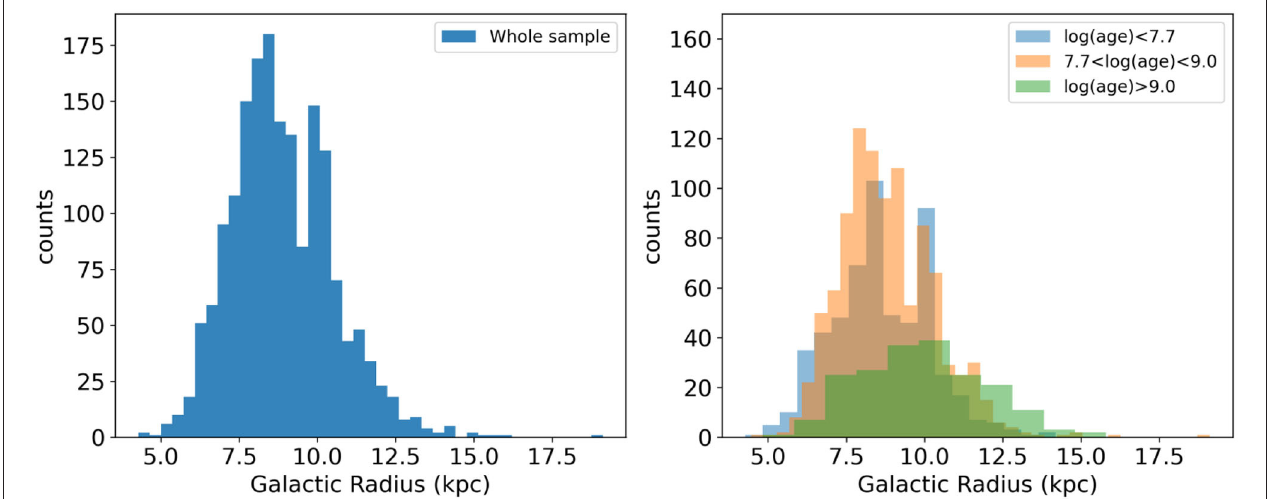
FIGURE 4 | The Galactocentric radial distribution of the open clusters sample with different age intervals. In the left-hand panel, the whole sample is presented. The minimum near 9.5kpc is the most evident structure. In the right-hand panel, we show the radial distribution of the objects separated in three age ranges: younger than log( age ) < 7.7, 7.7 ≤ log( age ) ≤ 9.0 and log( age ) > 9.0. We can see that the gap at 9.5kpc is much wider (about 1kpc width) and deeper in the younger cluster distribution. The gap is smaller in the intermediate age distribution and disappears in the older distribution. We interpret this as being due to open cluster’s radial migrations, that tends to fill the gaps with time. Note that the brown color is the effect of superposing blue and